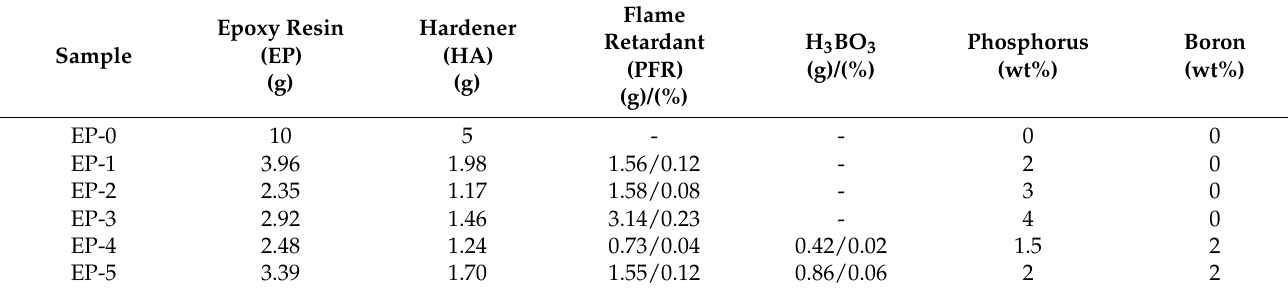
Table 1. Preparation details of epoxy resin